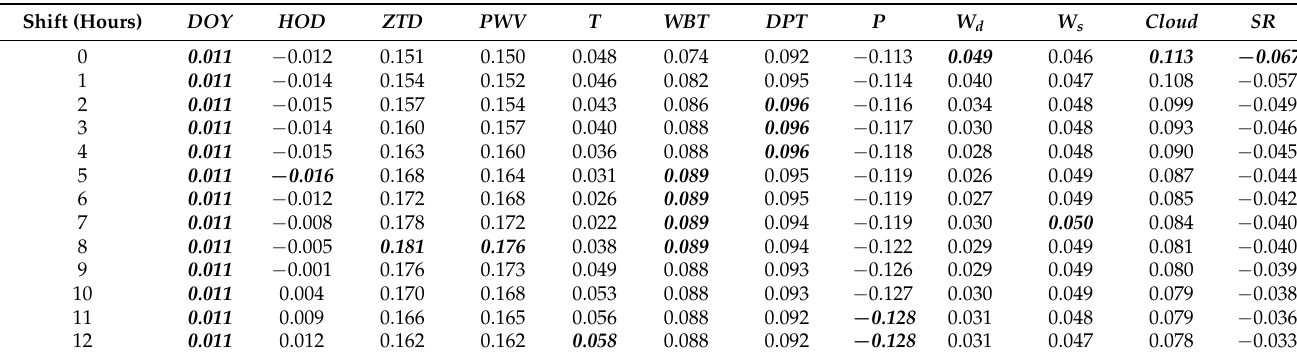
Table 4. Comparison of Pearson correlation coefficient results of each of the twelve variables with precipitation record moving 0 − 12 h